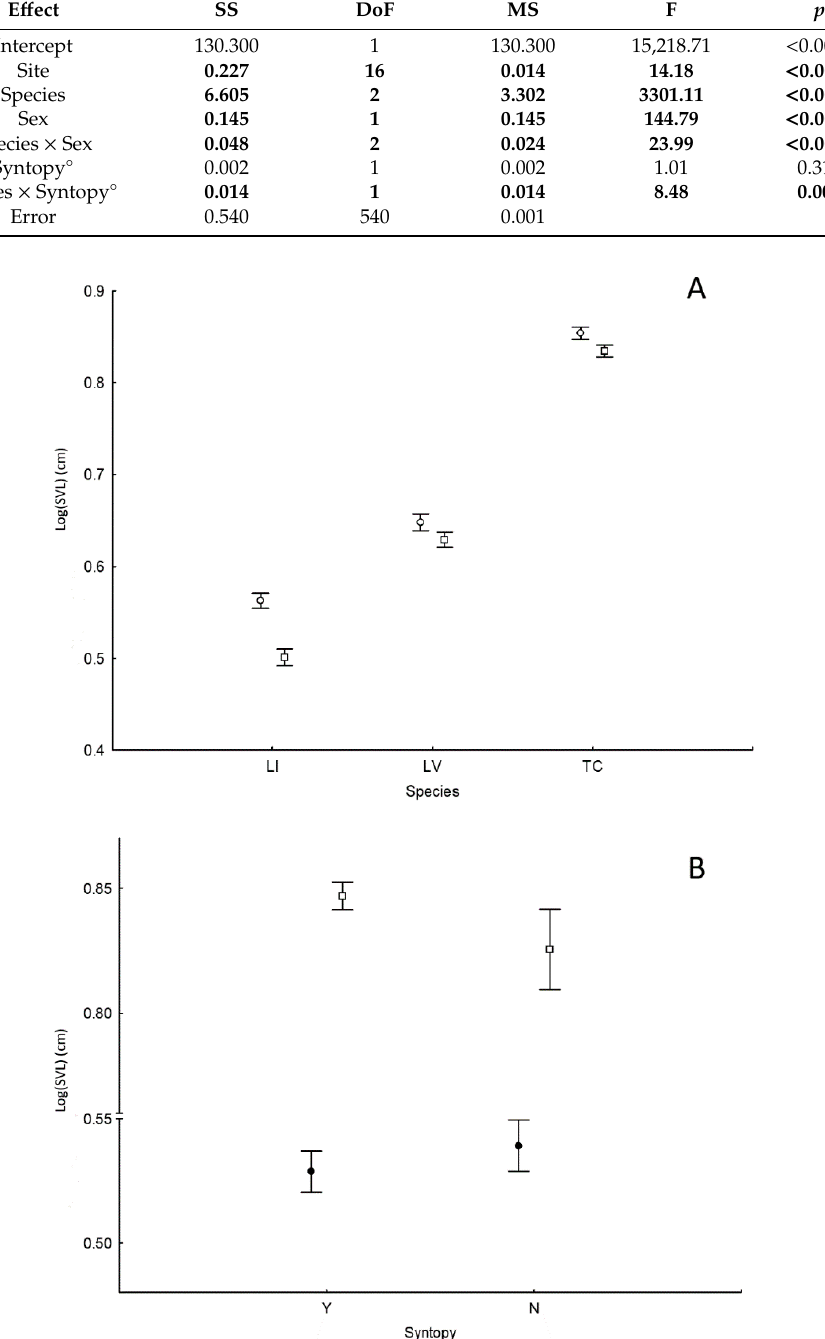
Figure 3. ( A ) Effect of species and sex on newt body size (SVL). LI = L. italicus ; LV = L. vulgaris ; TC = T. carnifex . Circles = females; squares = males. ( B ) Effect of syntopy on newt body size (SVL). Black circles = L. italicus ; empty squares T. carnifex . Y = two or more species co-occurring; N = single species. Lissotriton vulgaris was excluded from this analysis because it was always found in syntopic condition with the remaining species. Vertical bars denote 0.95 confidence intervals.